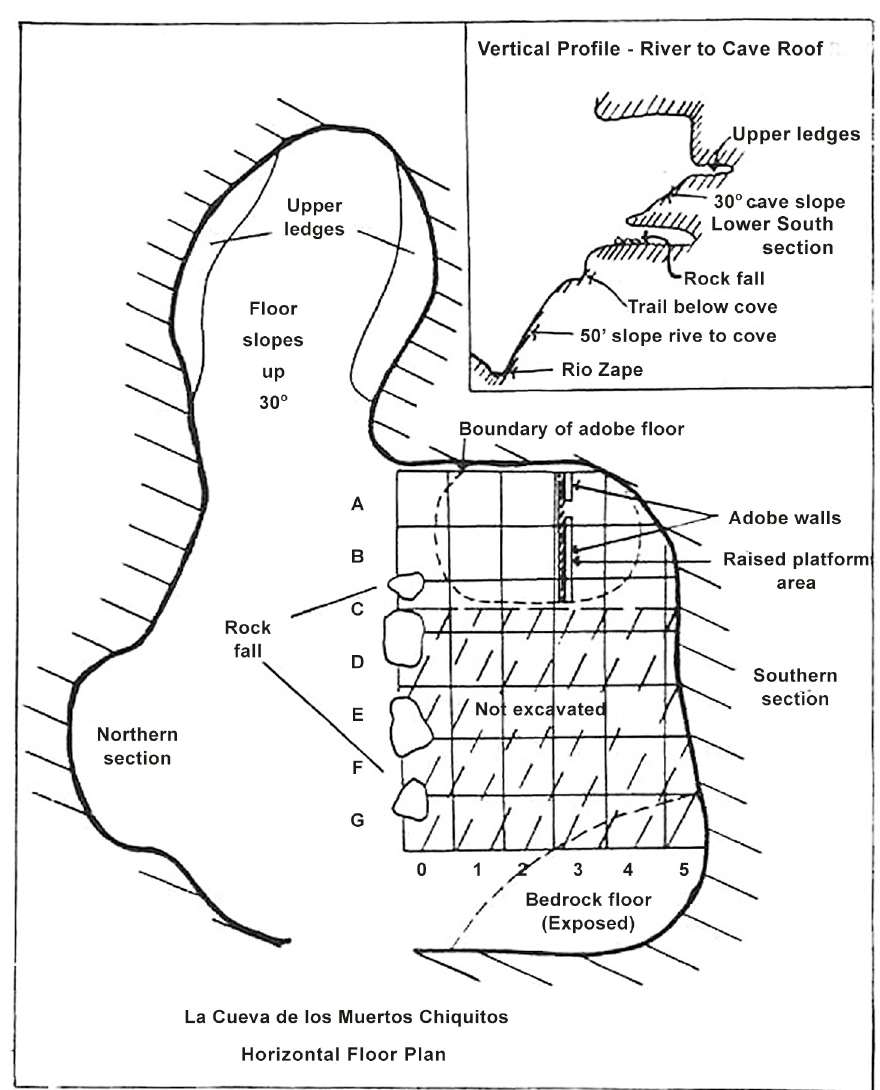
Fig 3. Map of La Cueva de los Muertos Chiquitos, Durango, Mexico. Map adapted from Brooks et al. [26].